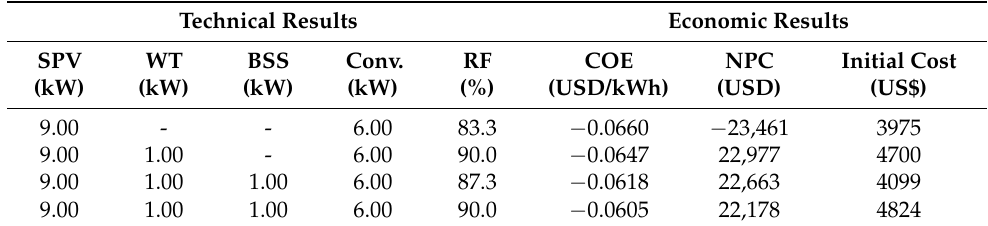
Table 4. Techno-economic planning results for Scenario 2.